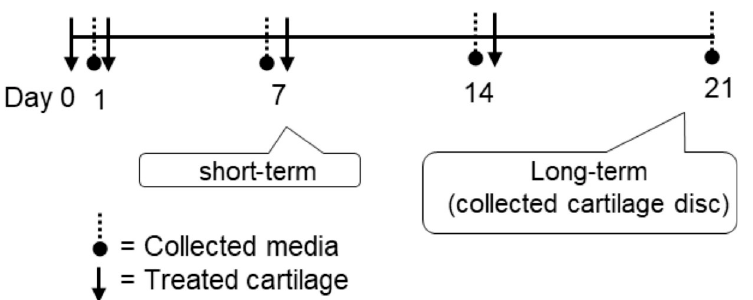
Fig 1. Timeline of treatments and sample collection for the assessment of chondroprotection in a cartilage explant culture model.